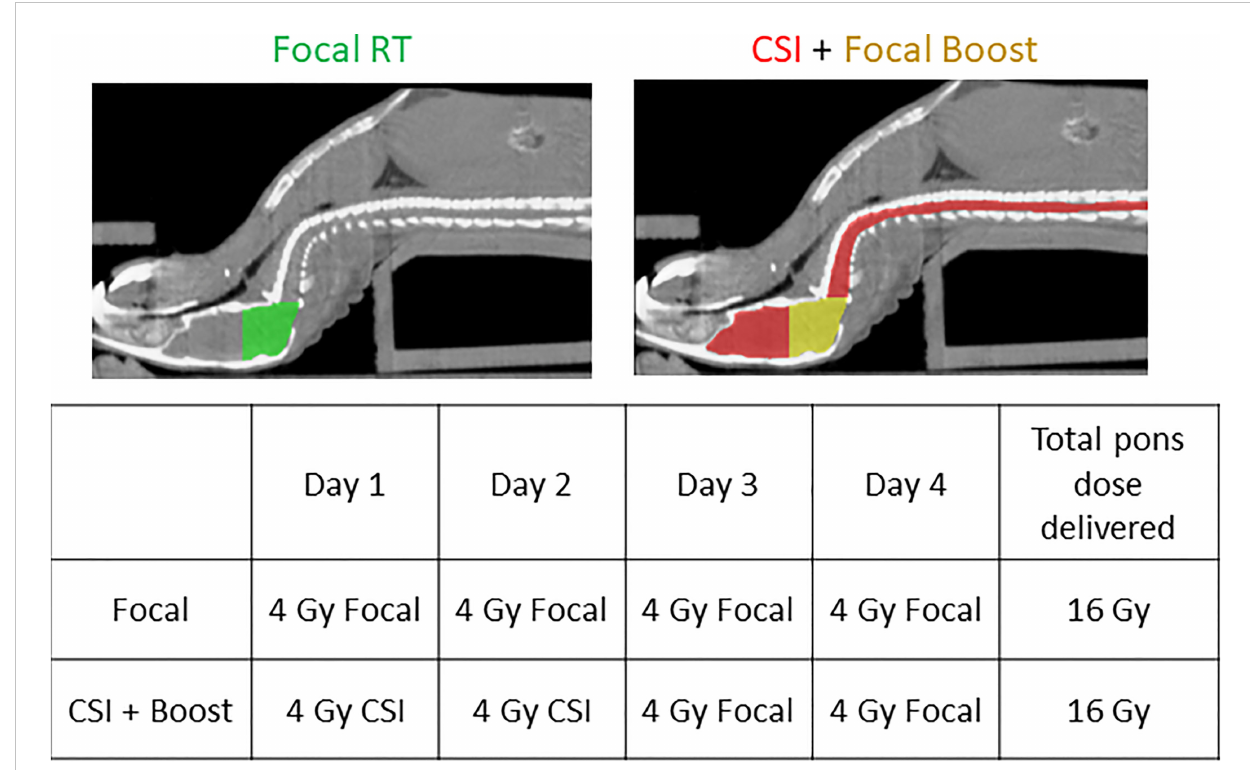
FIGURE 1 Planning CTs demonstrating positioning of the mouse on the custom platform and RT fi elds for the two RT groups, along with the RT schedule for both